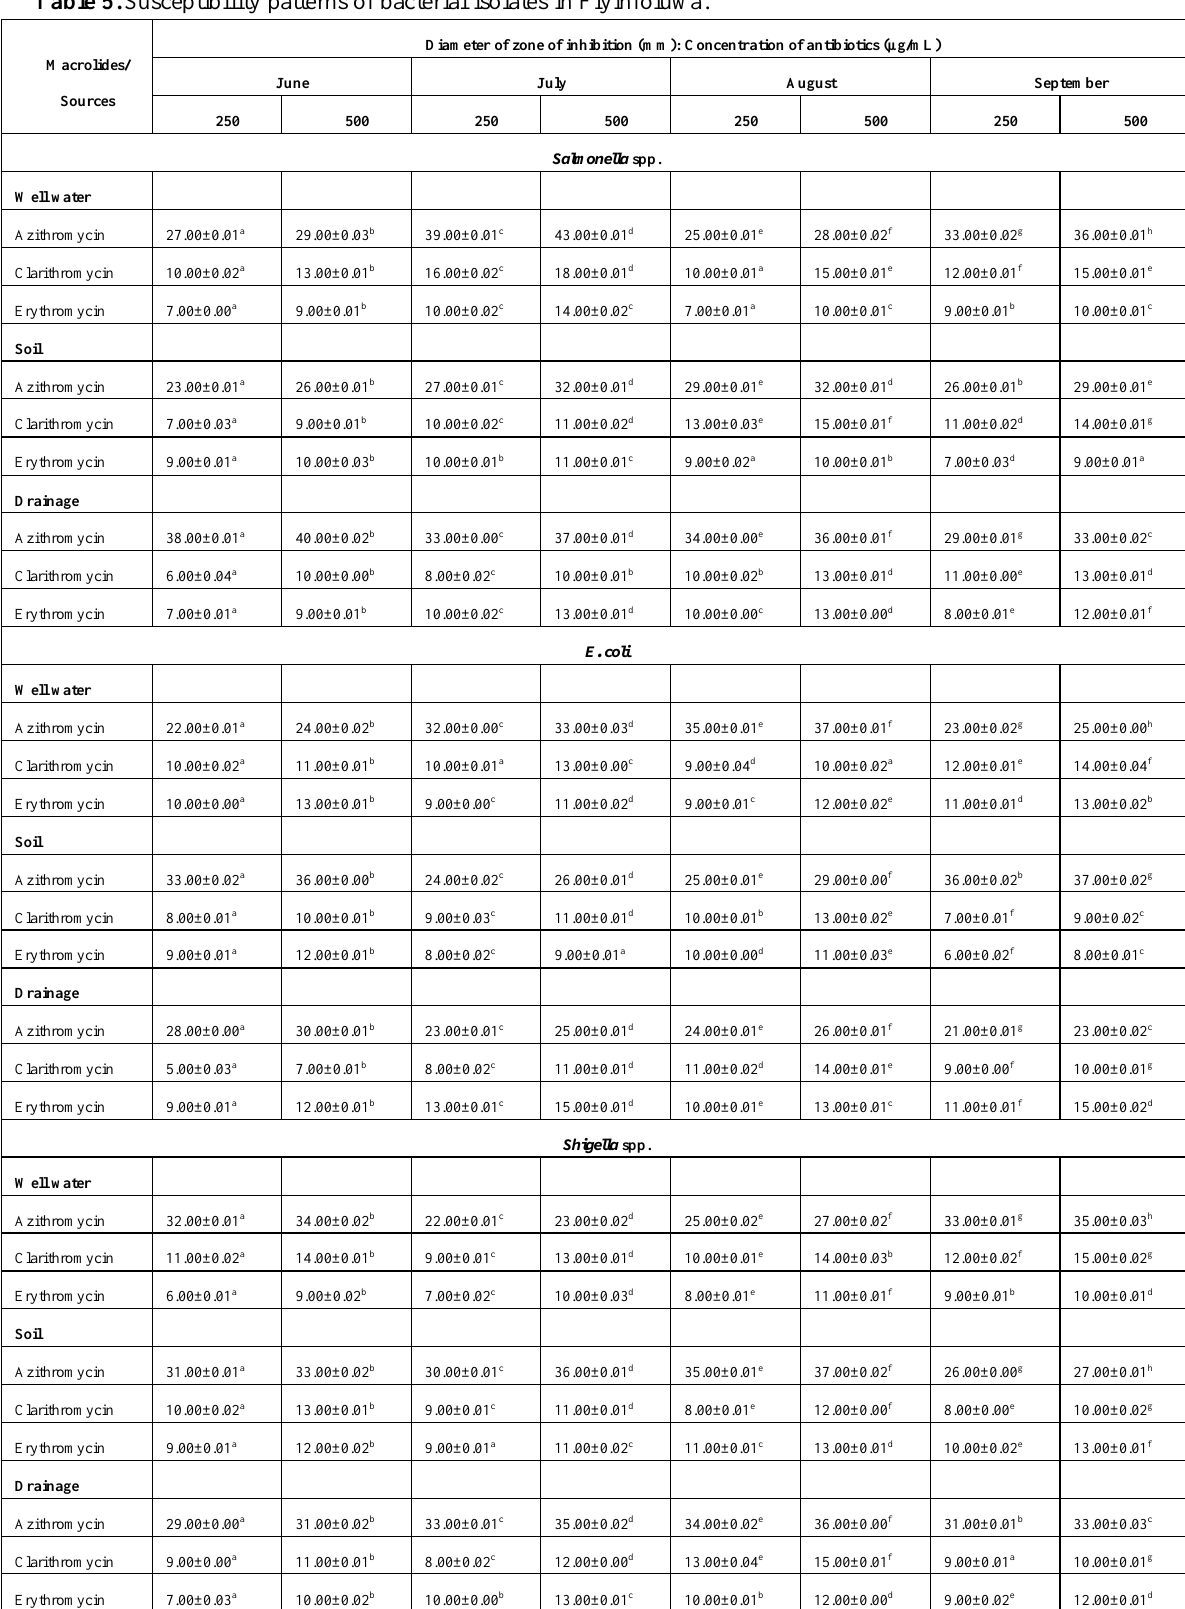
Table 5. Susceptibility patterns of bacterial isolates in